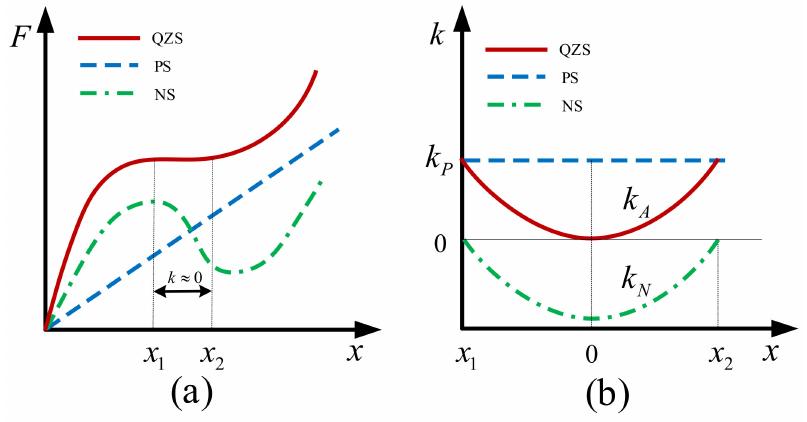
Figure 3. Principle of QZS vibration isolator: ( a ) Force-displacement relationship; ( b ) Stiffness- displacement